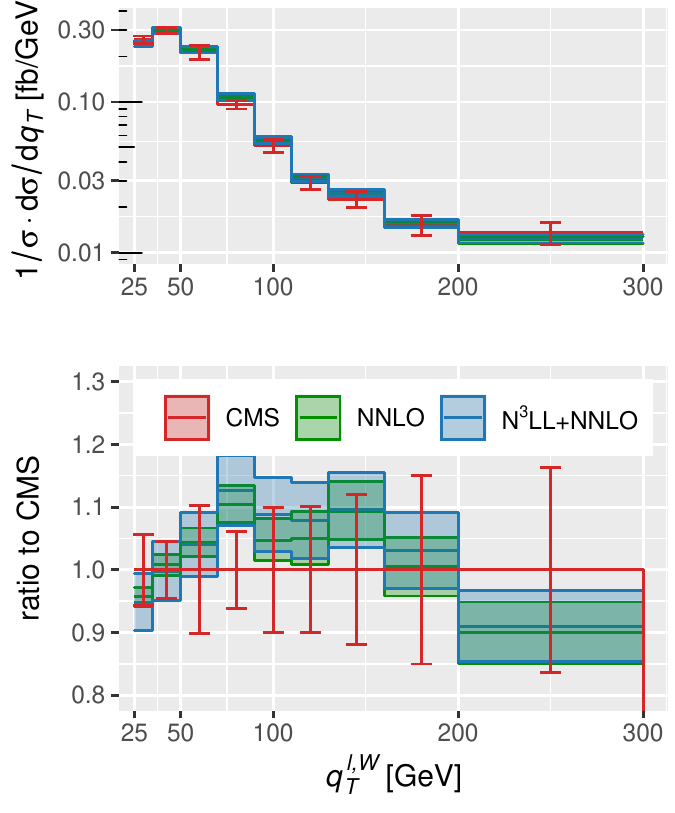
Figure 8 . The q ‘ W distribution for W ± Z at NNLO and N 3 LL+NNLO compared to the CMS data T from ref.